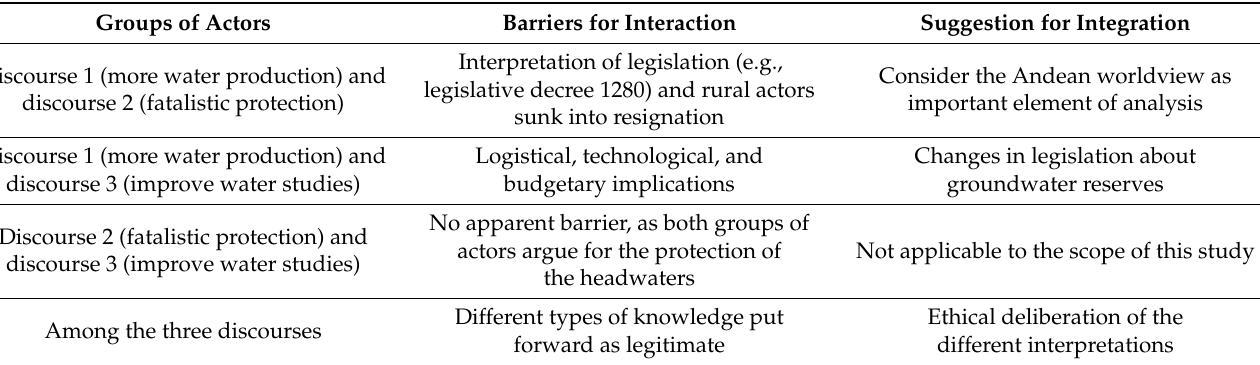
Table 3. Barriers to interaction and suggestions for stakeholders